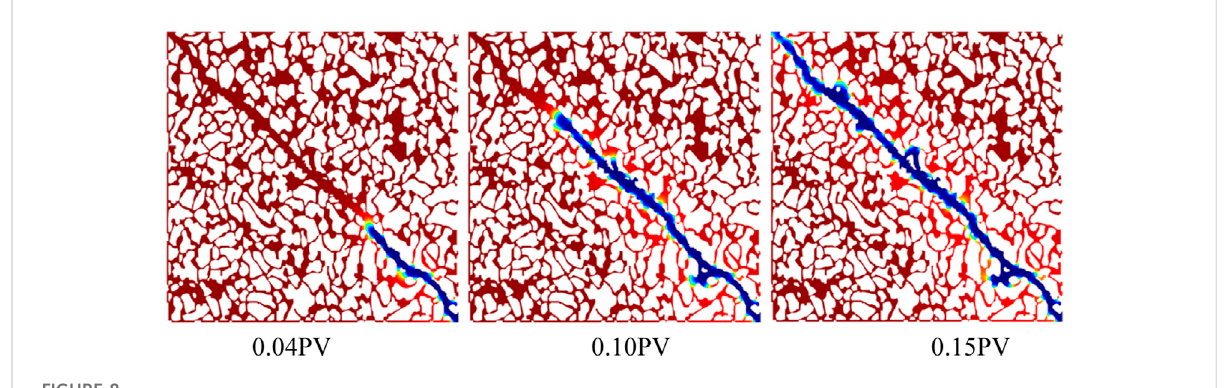
FIGURE 8 Water drive front of the vertical fracture